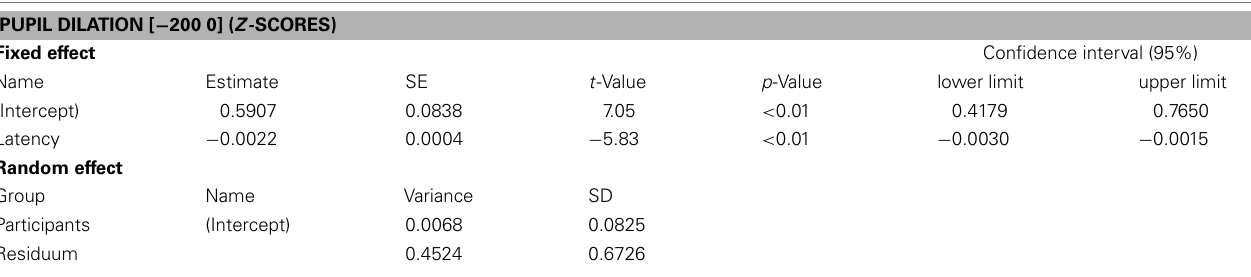
Table 2 | Summary of the mixed-effects model for pupil dilation ( z -scores) as a function of saccade latency (ms). PUPIL DILATION [ − 200 0] ( Z